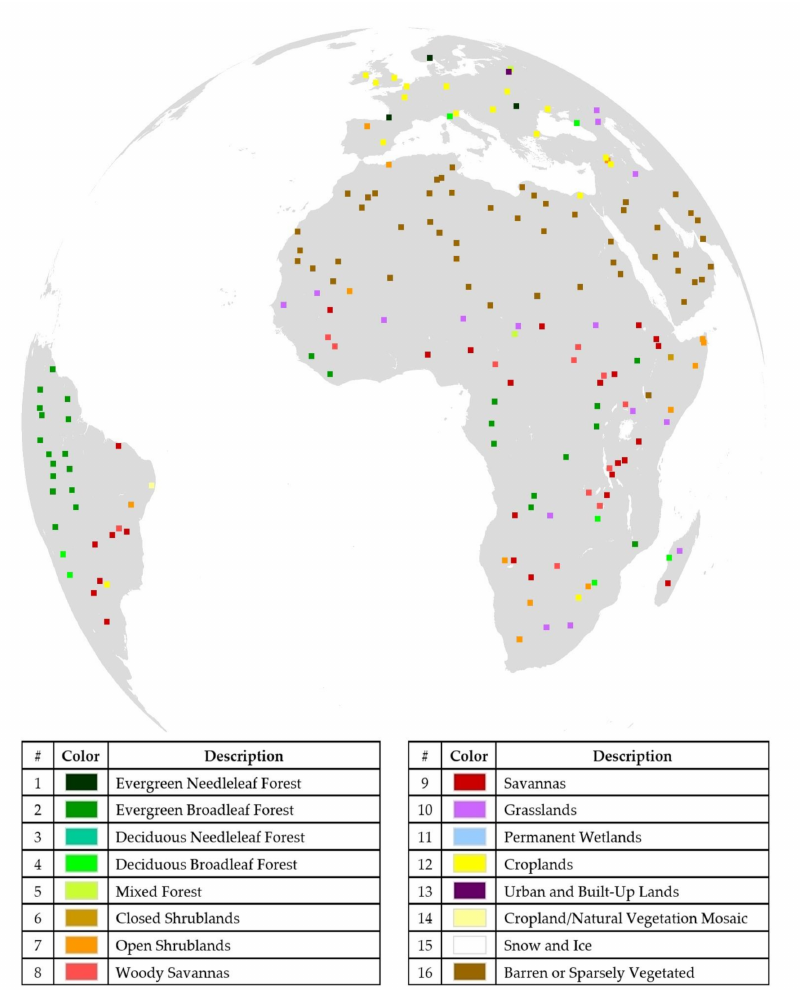
Figure 1. Location of all BEnchmark Land Multisite ANalysis and Intercomparison of Products (BELMANIP) sites used in the study and their corresponding International Geosphere Biosphere Programme (IGBP)